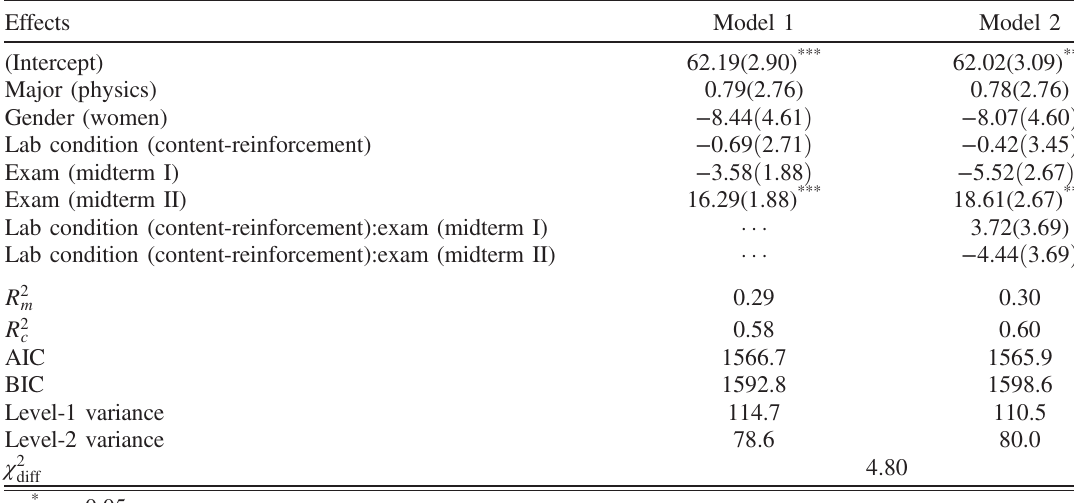
Table XII includes a selection of models tested in the forward stepwise regression performed on E-CLASS data from students from semester 1. Table XIII details descrip- tive statistics for the three semesters that the E-CLASS is administered in the course including for both the full dataset and the subset used in the main text analyses. TABLE XI. Mixed model analysis of students ’ exam performance in the subsequent introductory electricity and magnetism course that immediately follows semester 1. All exams are scored out of 100. Students who do not have scores for all exams are removed from the analysis. There are 65 participants in this analysis. The reference group is exam (final), major (nonphysics), gender (men), and lab condition (experimentation). We use the same models and packages to perform the analysis as those in Table